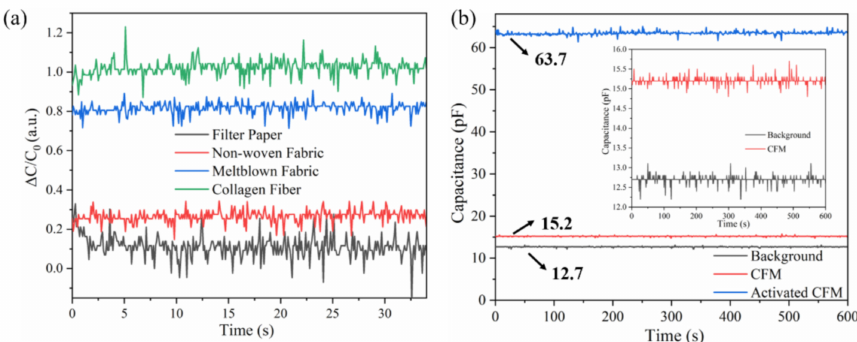
Figure 5. Comparison of ( a ) ∆ C / C 0 for the sensors with four different dielectric layers under the same pressure and ( b ) sensing response of the CFM before and after immersion in the ionic